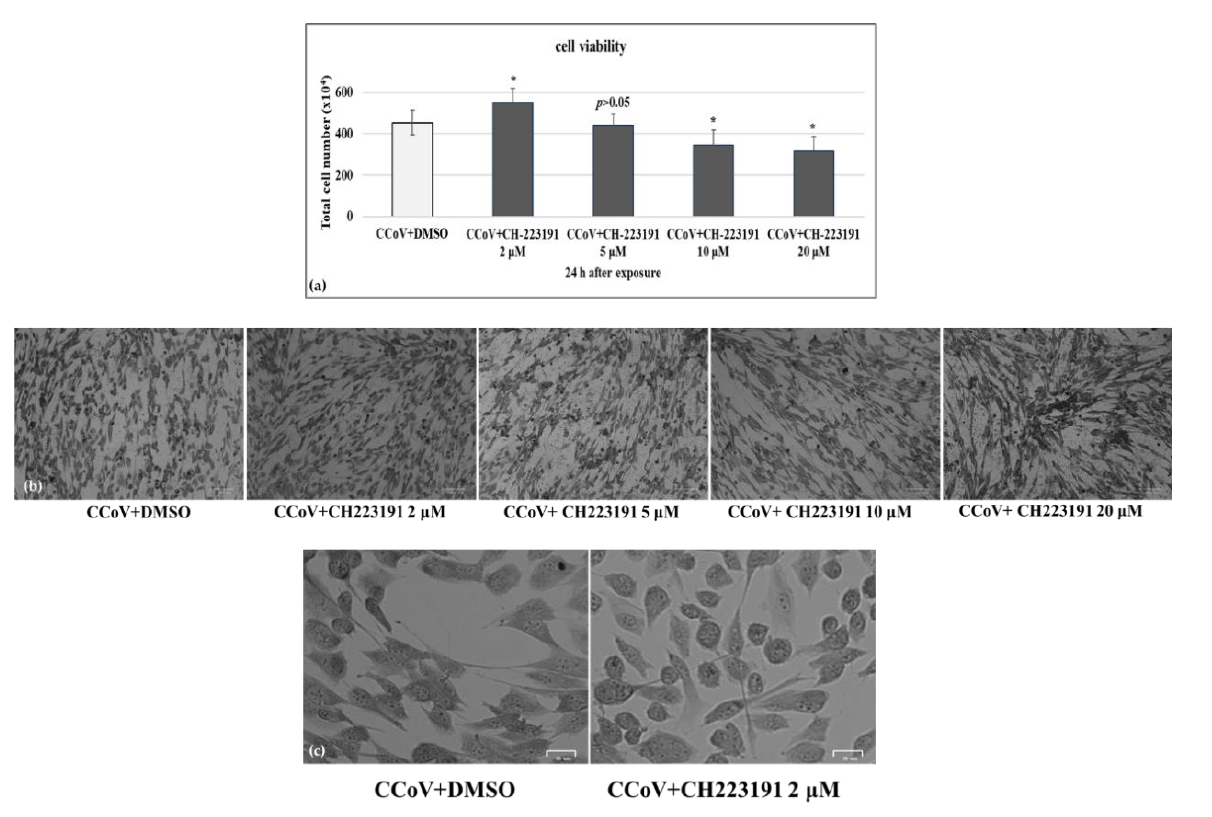
Figure 2. AhR inhibitor CH223191 increases cell viability during CCoV infection. ( a ) Dose–response curve of A72 cells treated with CH223191 at different concentrations (2, 5, 10 and 20 µ M). After 24 h of treatment, cell viability was determined by TB staining while cells were attached to wells and counted under a light microscope. Significant differences between CCoV+DMSO and CCoV+CH223191-treated cells are indicated by probability p . * p < 0.05. ( b ) A72 cells infected with CCoV and treated or untreated with CH223191 at different concentrations (2, 5, 10 and 20 µ M). At 24 h after treatment, cells were stained with Giemsa and observed under a light microscope. Scale bar 100 µ m. ( c ) A72 cells infected with CCoV and treated or untreated with CH223191 (2 µ M). At 24 h after treatment, cells were stained with Giemsa and observed under a light microscope. Scale bar 25 µm.